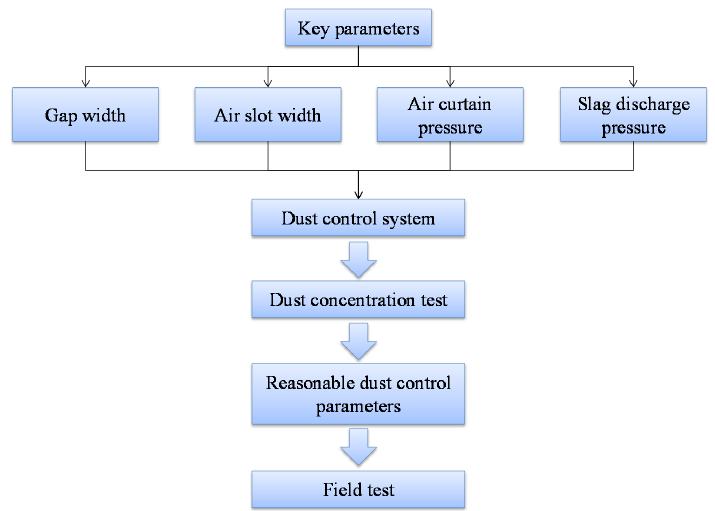
Figure 4. Parameter optimization process of dust control system.